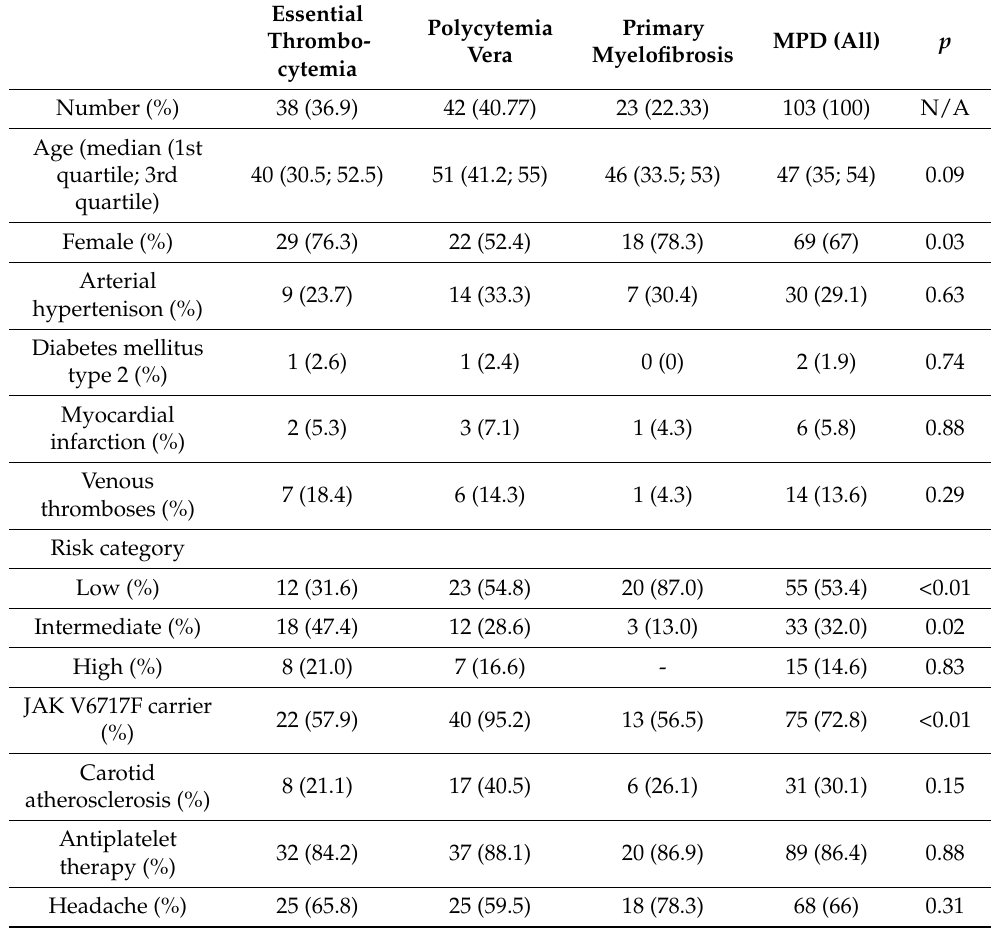
Table 1. The prevalence of the main risk factors for